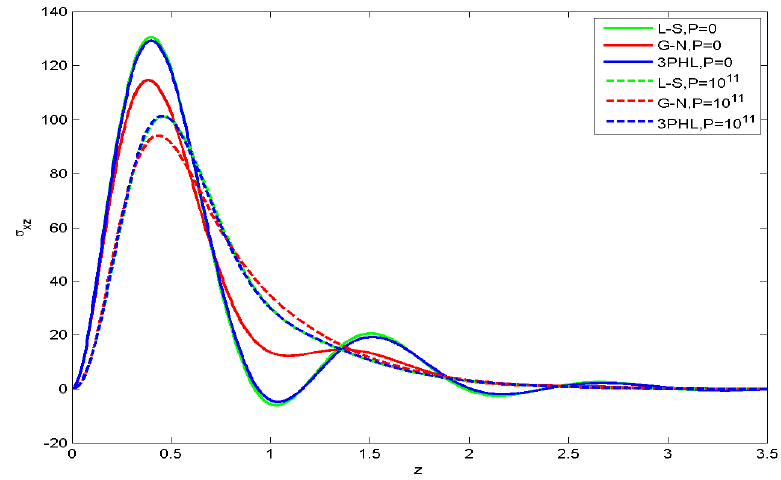
Figure 6. Shear stress σ xz concerning z under thermoelastic theories.